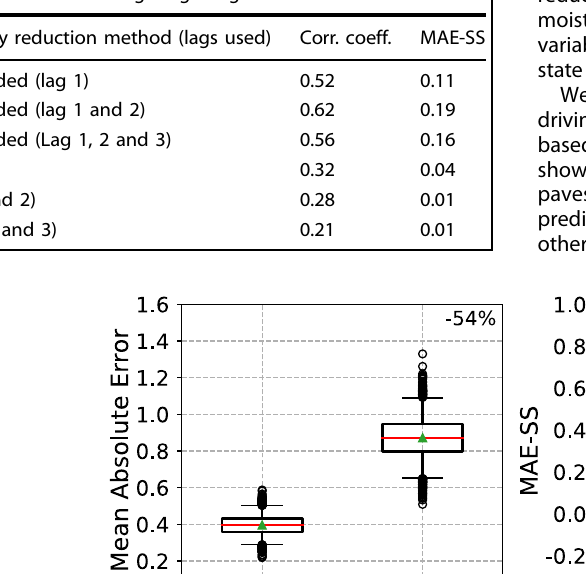
Table 2. Veri fi cation of July – August (JA) mean eastern US temperature predictions using Ridge Regression.